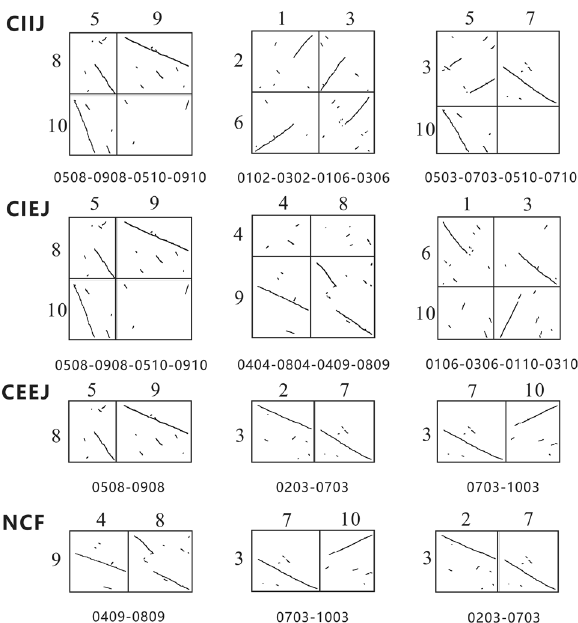
Figure 3. Search results of chromosome rearrangement pattern in Brassica rapa reconstruction genome. Note: The combination name is formed according to the clockwise direction of the comparison units, the comparison unit name consists of horizontal and vertical chromosome numbers.